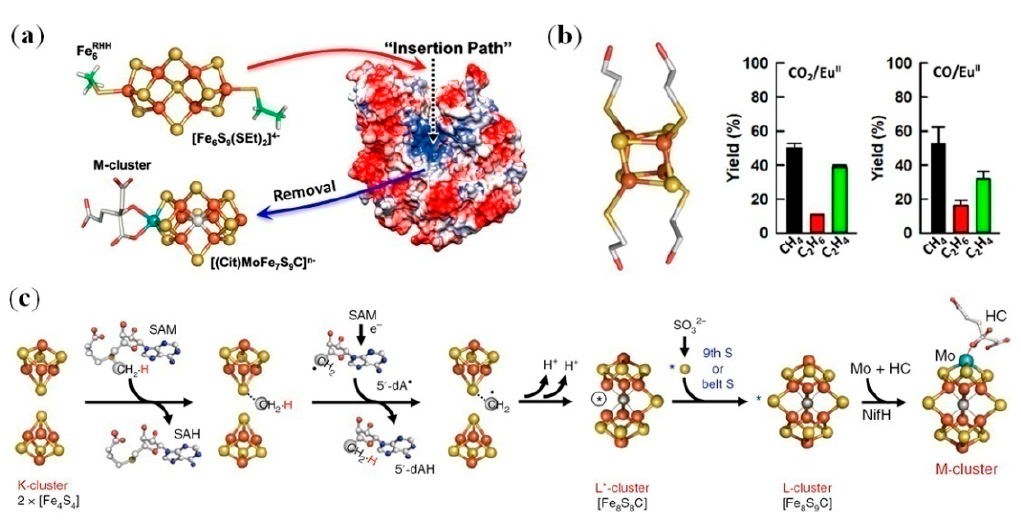
Figure 7. ( a ) An artificial metalloenzyme constructed by replacement of the M-cluster with a synthesized [Fe 6 S 9 (SEt) 2 ] 4 − cluster in nitrogenase scaffold. Reprinted with permission from [102]. Copyright 2015 Wiley-VCH; ( b ) The structure of [4Fe-4S(SCH 2 CH 2 OH) 4 ] 2 − cluster (left), and its catalysis of CO 2 /CO reduction in the presence of europium(II) diethylenetriaminepentaacetic acid (Eu II -DTPA) (right) [104]. Copyright 2018 Nature press; ( c ) The proposed mechanism of L -cluster assembly in nitrogenase, followed by the maturation of M-cluster. SAM: S-adenosyl- L -methionine; NifH: the reductase component of Mo-nitrogenase;HC:homocitrate. Reprinted with permission from [103]. Copyright 2018 Macmillan Publishers.